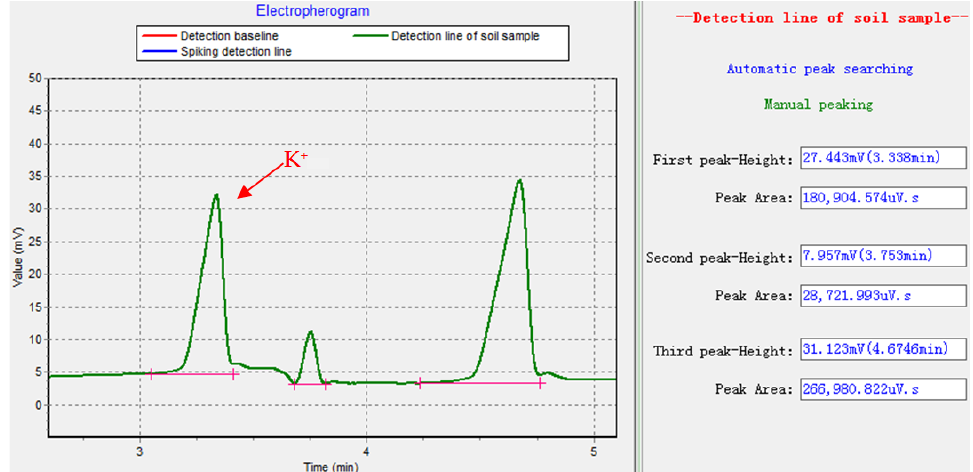
Figure 4. Peak height and peak area of the electropherogram for soil sample B 1 .